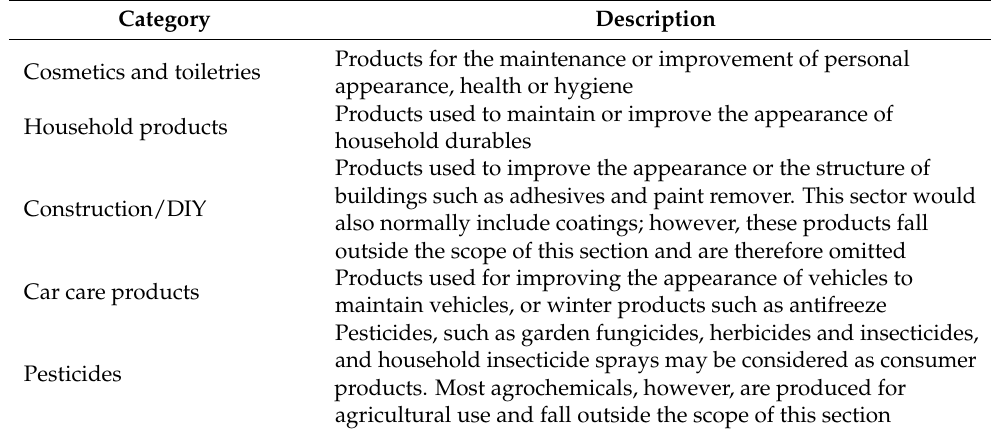
Table 2. Main categories with regard to the domestic use of